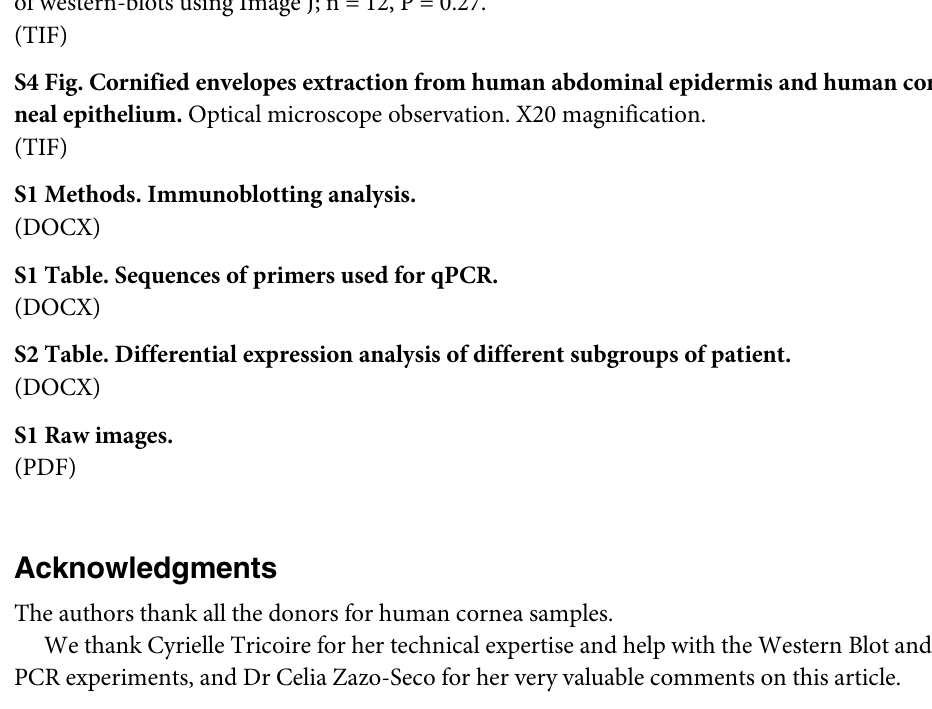
S4 Fig. Cornified envelopes extraction from human abdominal epidermis and human cor- neal epithelium. Optical microscope observation. X20 magnification.